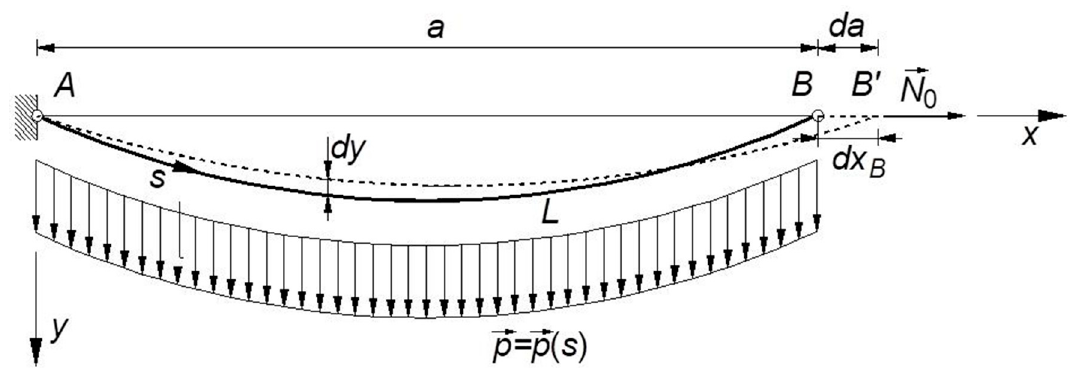
Figure 3. Cable running over a fixed pulley in 𝐵 , i.e., 𝑎 = const .